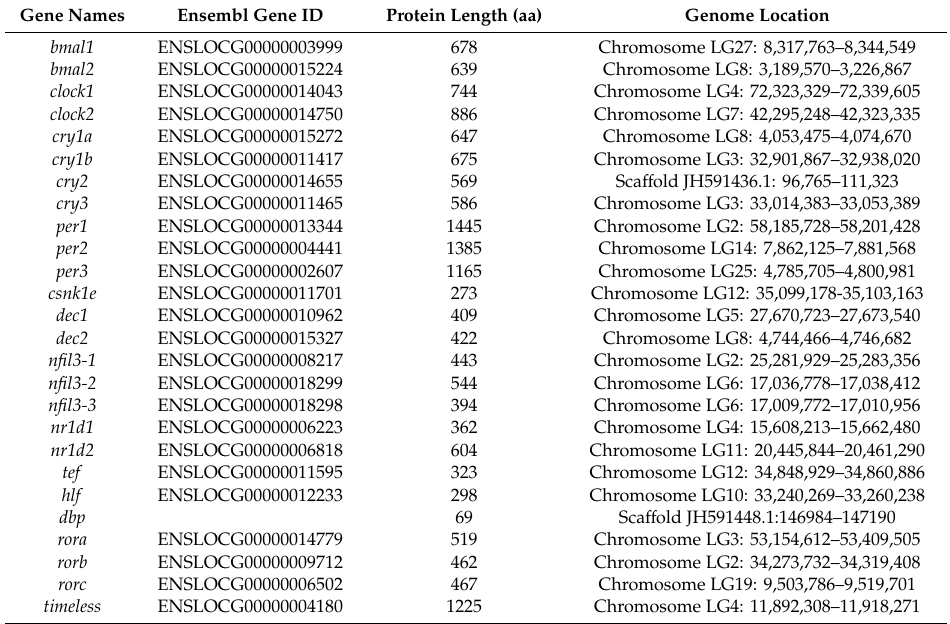
Table 1. Circadian clock genes in spotted gar